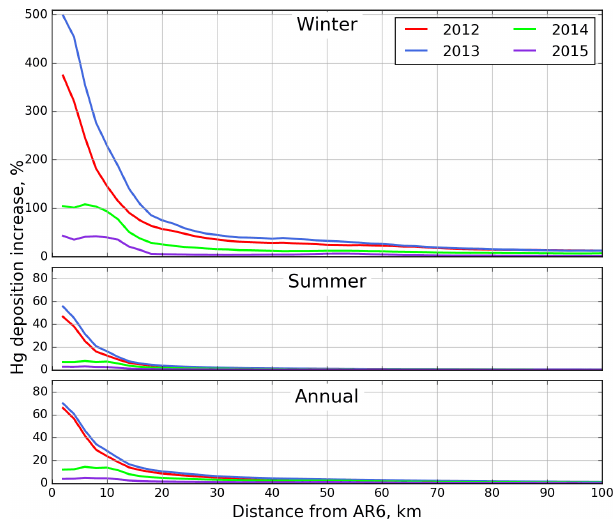
Figure 16. Average Hg deposition enrichments (%) due to Athabasca oil sands emissions in winter from December to Febru- ary (top), in summer from June to August (middle), and annually (bottom) for 2012 (red), 2013 (blue), 2014 (green) and 2015 (pink) by distance from